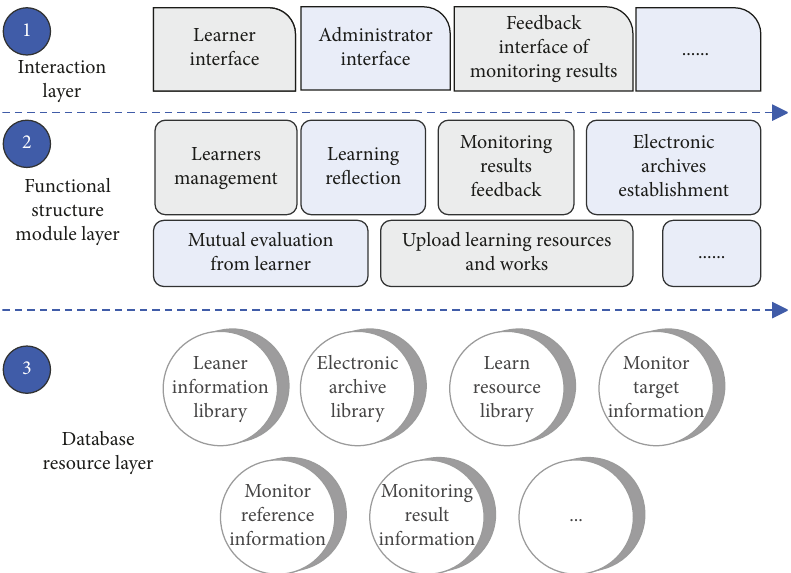
Figure 8: The structure of the school labor education system based on the information environment.